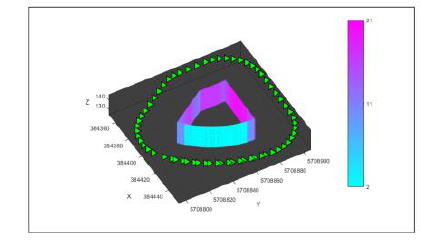
Figure 7 Visibility check for a curved